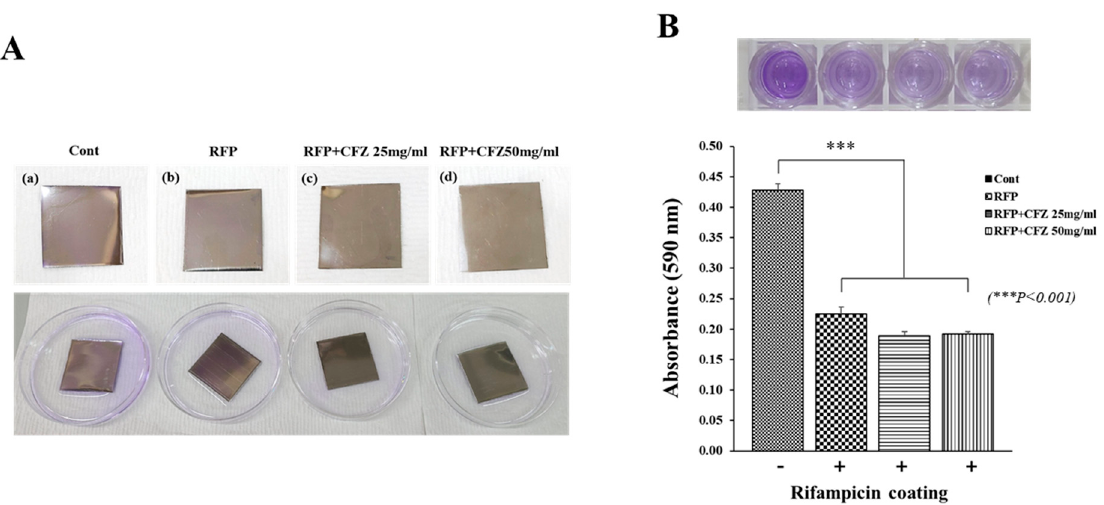
Figure 4. Staphylococcus aureus biofilm formation on stainless steel coupons: ( A ) Biofilm formation assays of S. aureus strains. Formed biofilm was stained with 0.1% crystal violet. ( B ) Quantification of S. aureus biofilm formation. S. aureus biofilm